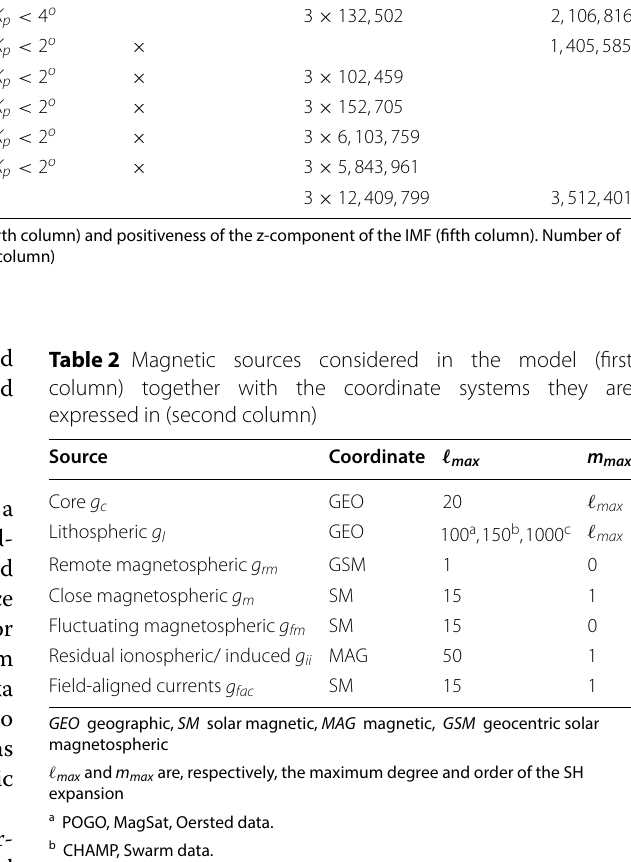
Table 1 Dataset used to derive the model. Missions (first column) and their time span (second column) Mission